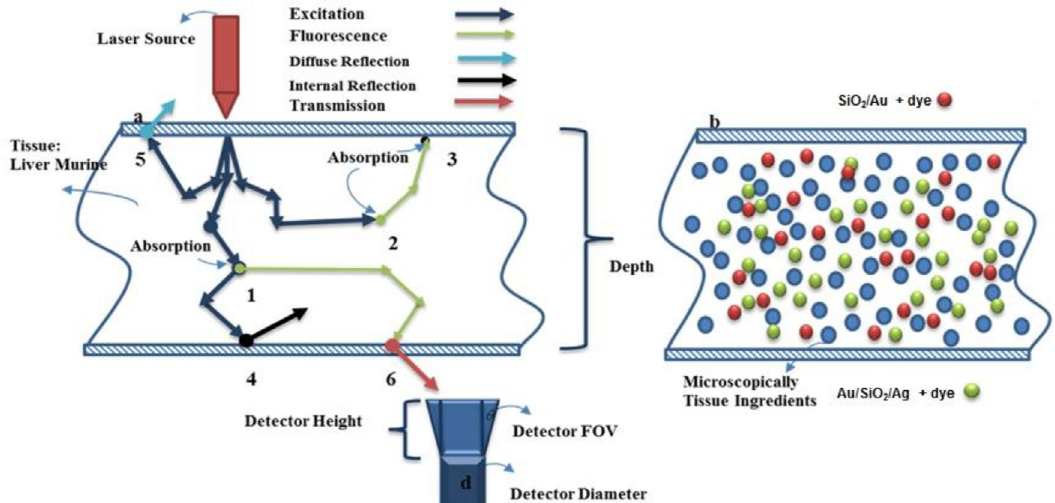
Fig. 1. (a) Schematic of the interaction of light with tissue (Absorption, scattering, diffuse reflection, Internal reflection, and transmission) and (b) microscopic view of the tissue’s ingredients and randomly diffusion of NPs into